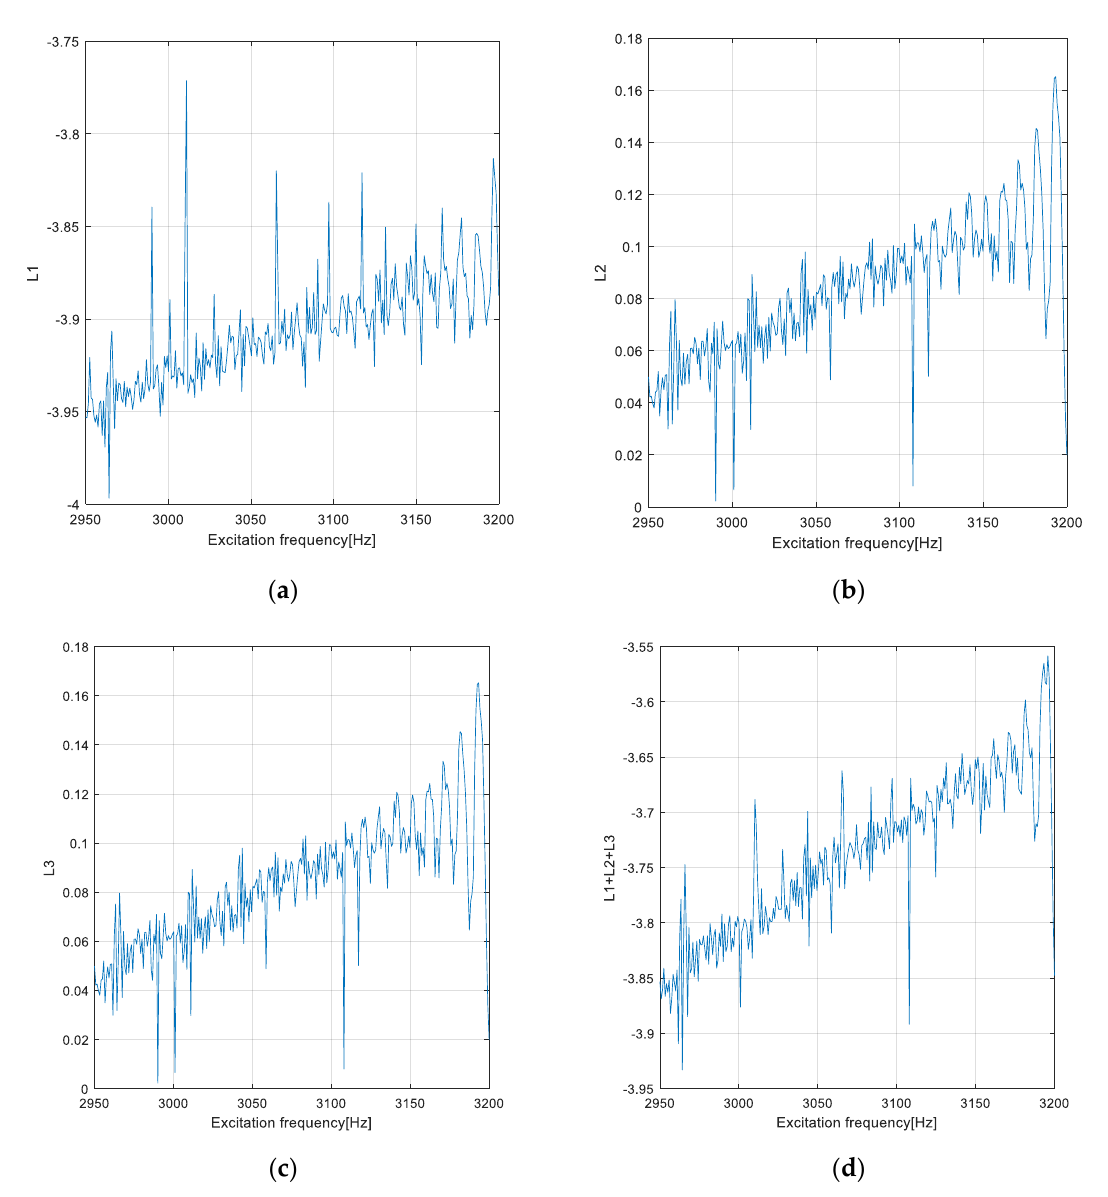
Figure 19. Lyapunov exponents of NFTV for DIE1, β